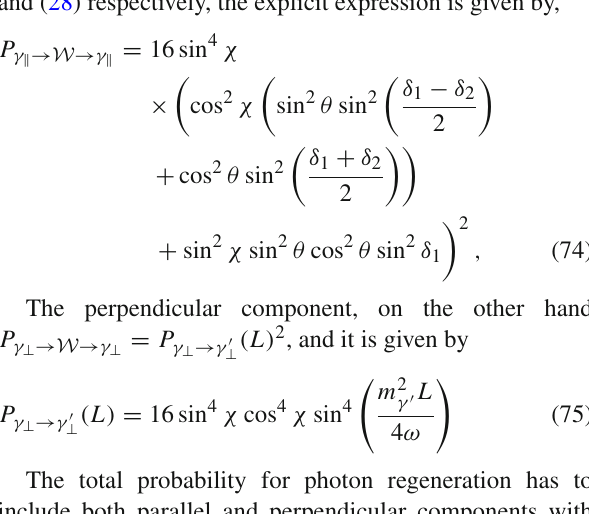
Fig. 4 Exclusion plots for axion-like particles using a LSW setup with parameters L = 5 . 5 m, B = 5 . 5 T, ω = 2 . 33 eV. We considered HP masses m γ (cid:4) = 10 − 5 , 10 − 6 eV and several coupling to photons. The dashed lines corresponds to f i → | x | = χ = 10 − i . Above the dashed line we have | x | < χ , thus a strong mixing regime and below the dashed line we have the weak mixing regime. The empty stripes and empty rounded zones correspond to sensitivity gaps